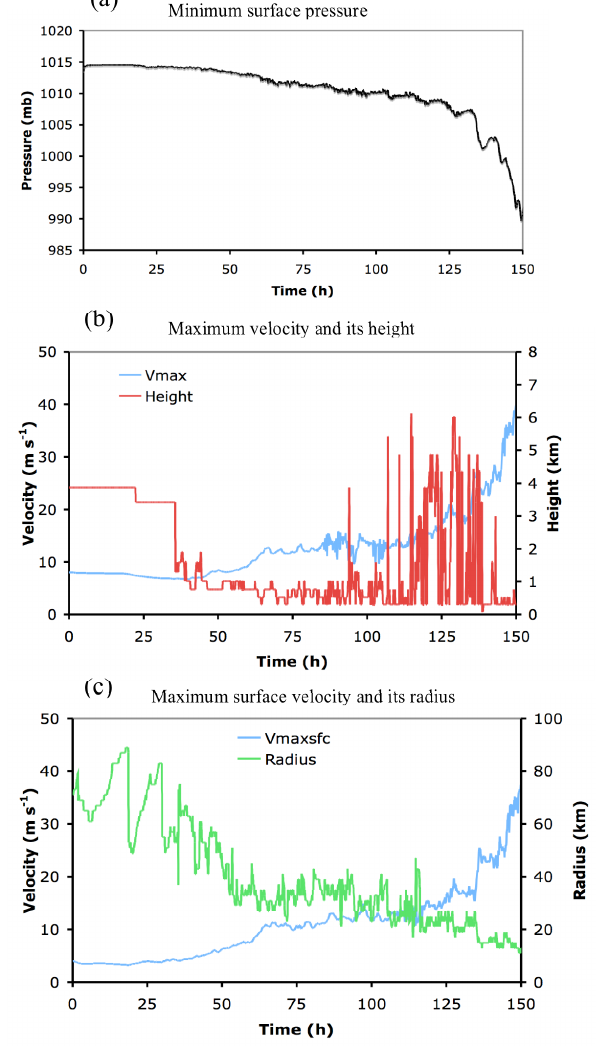
Figure 9. As in Figure 2, for Experiment 6. Fig. 9. As in Fig. 2, for Experiment 6. Figure 10. As in Figure 2, for Experiment 7. Fig. 10. As in Fig. 2, for Experiment